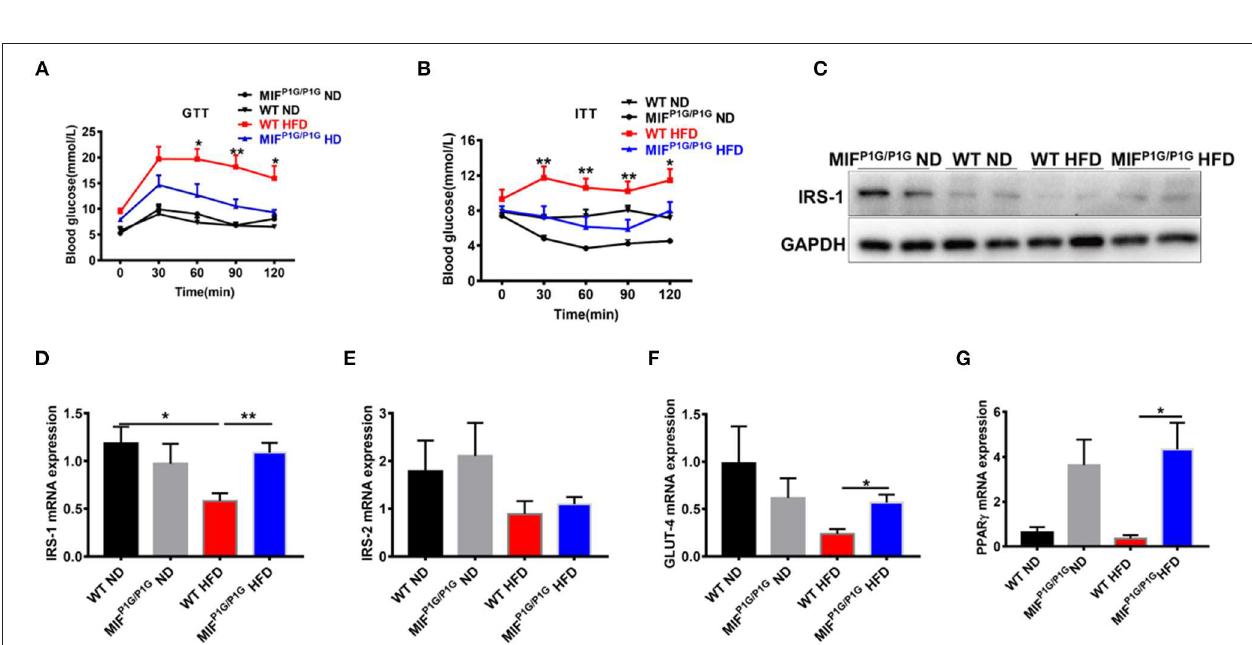
FIGURE 4 | MIF P1G / P1G mice ameliorated HFD-induced insulin resistance. (A) Glucose tolerance test (GTT) was examined in WT and MIF P1G / P1G mice fed ND or HFD for 10 weeks after 16h fasted. (B) Insulin tolerance test (ITT) was examined in WT and MIF P1G / P1G mice fed ND or HFD for 11 weeks after 4h fasted. (C) The images of IRS1 protein by Western blot analysis in adipose tissue from WT and MIF P1G / P1G mice fed ND or HFD. (D–G) The expression of IRS1, IRS-2, GLUT4, and PPAR γ by real-time PCR analysis in adipose tissue from the two group mice. Data are shown as mean ± SEM, * p < 0.05, ** p < 0.01, n = 4–5 per group.